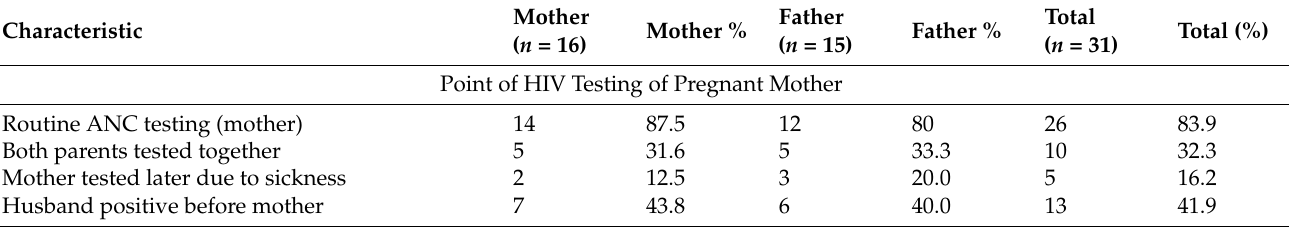
Table 1. Socio-economic and related characteristics of PMTCT